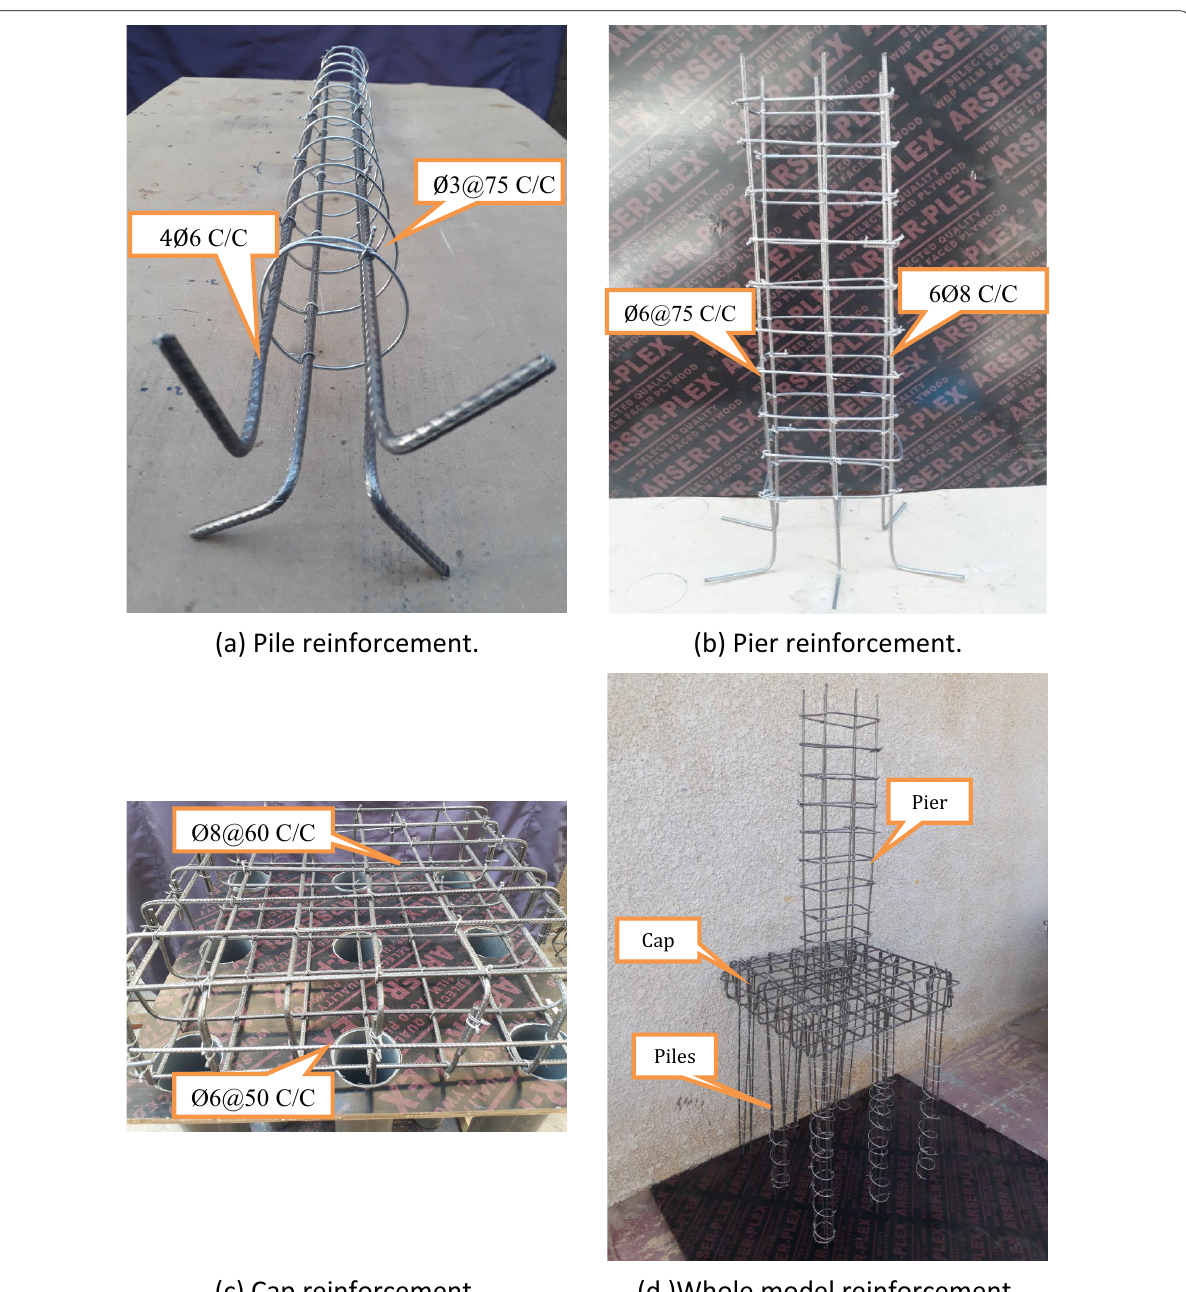
Fig. 3 Prefabricated steel of the model reinforcement, all dimensions in